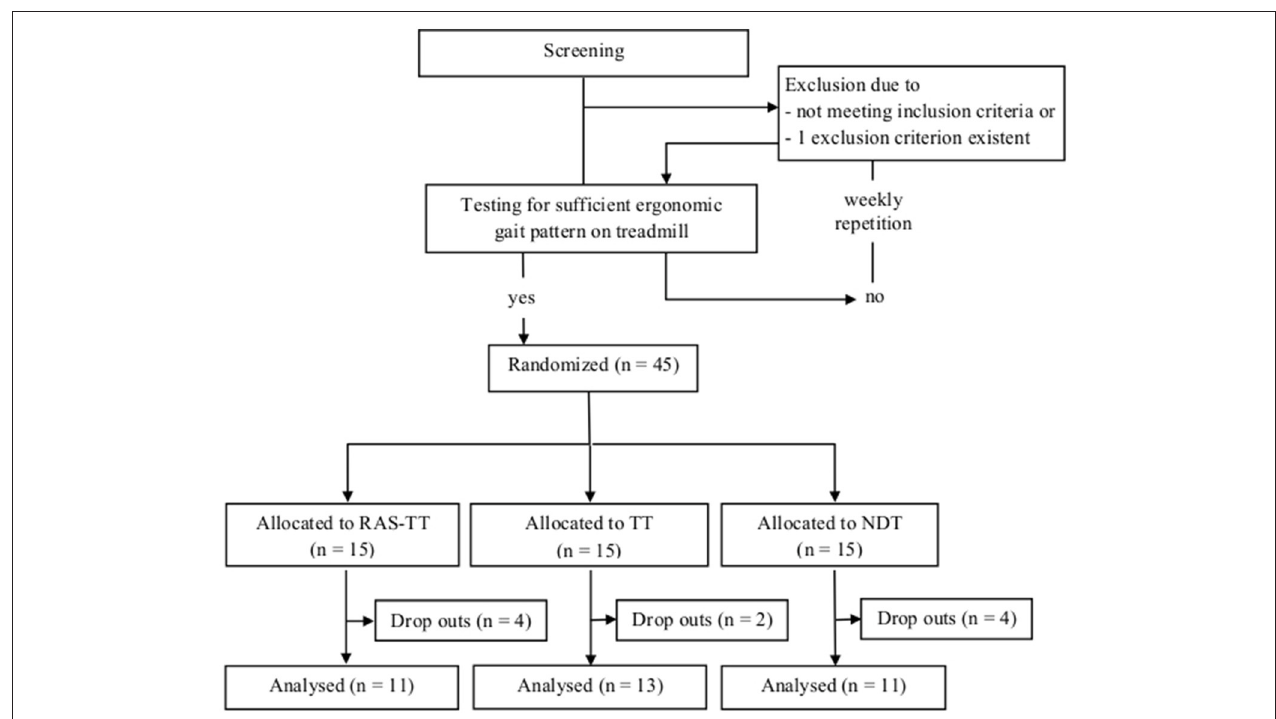
FIGURE 1 | Patient flow chart of study design. RAS-TT, rhythmic auditory stimulation on treadmill; TT, treadmill training; NDT, neurodevelopmental treatment.